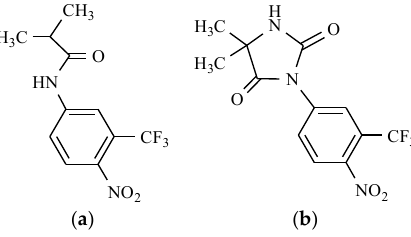
Figure 6. Anticancer drugs: ( a ) Flutamide; and ( b ) Nilutamide.